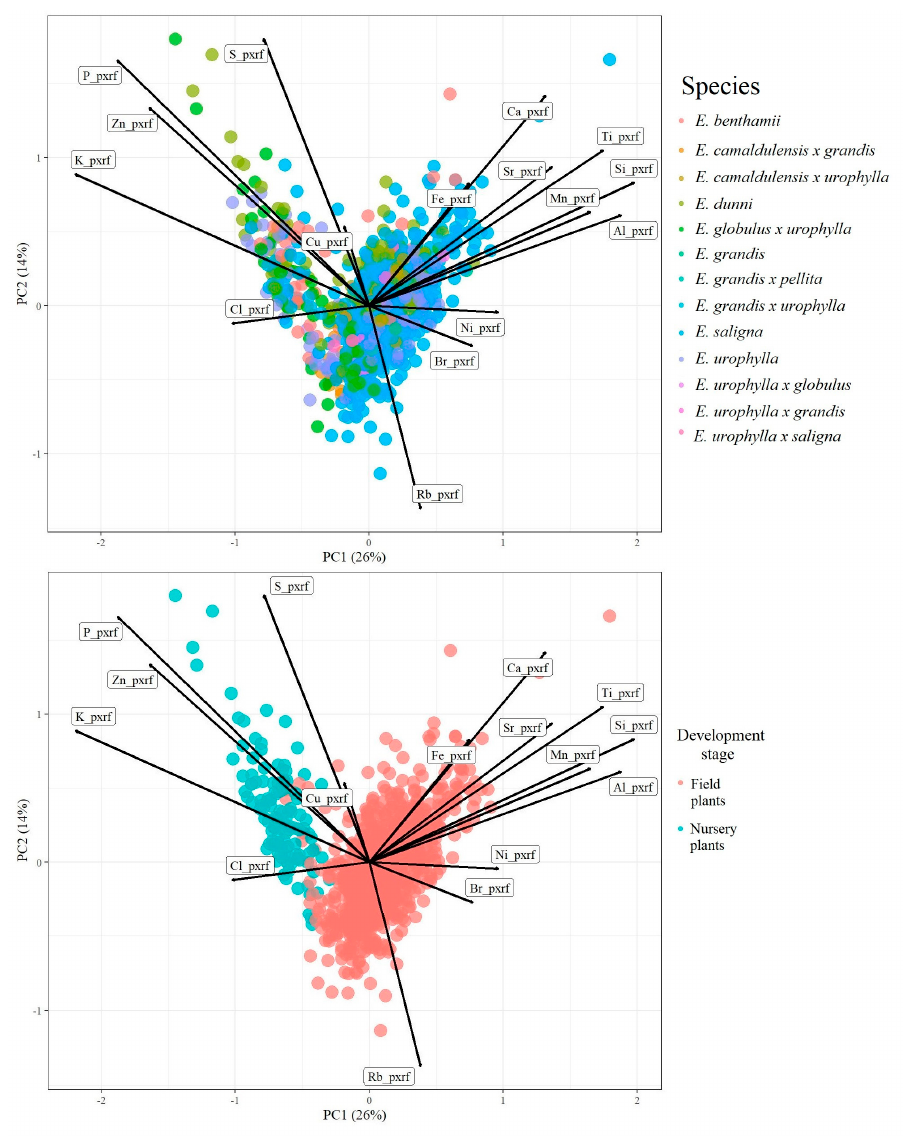
Figure 1. Principal component analysis (PCA) of portable X-ray fluorescence (pXRF) elemental data for Eucalyptus spp. leaves in different development stages.